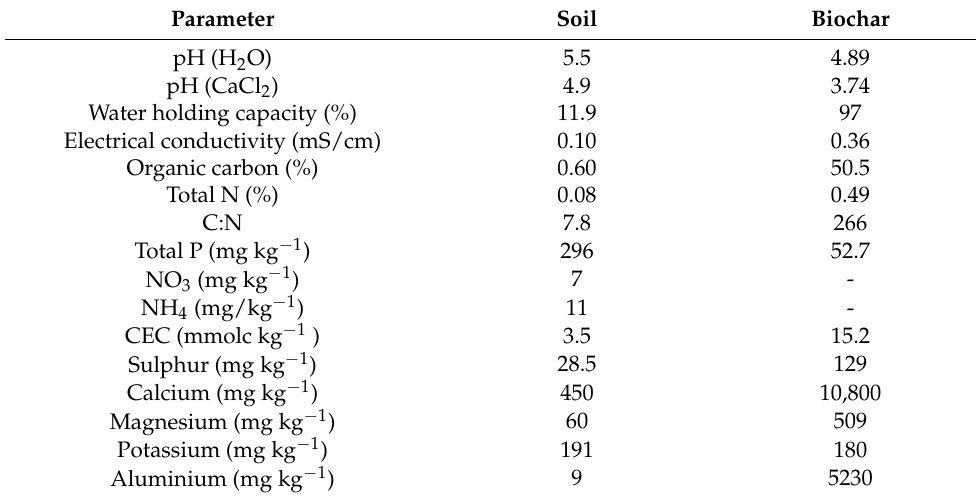
Table 1. Chemical characteristics of the field soil and